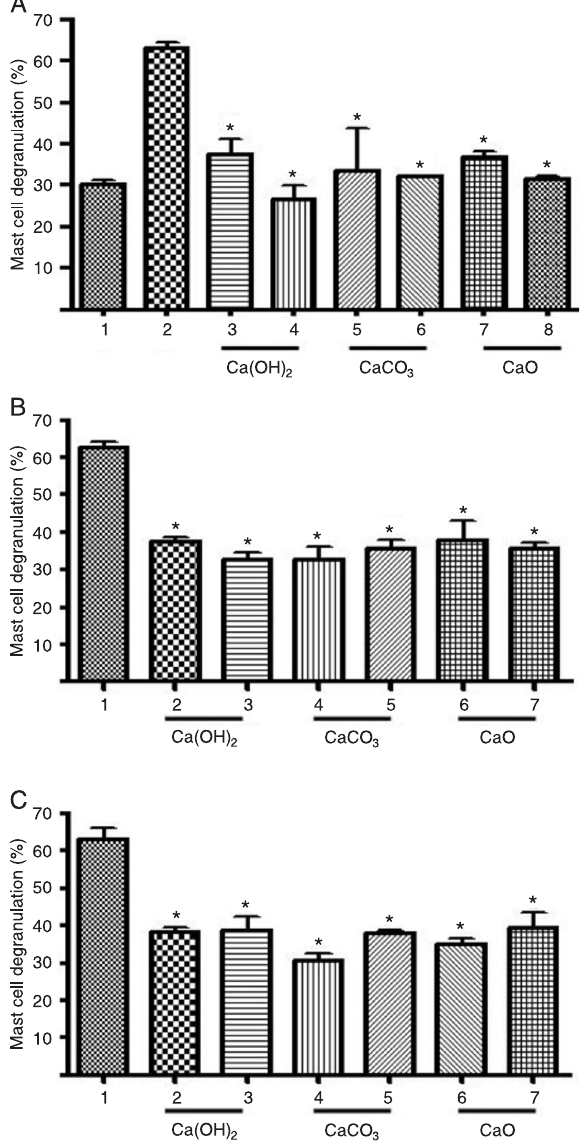
Figure 5. Mast cell degranulation after calcium treatment. A , 1 = Control cells; 2 = 2S albumin pool plus 2S albumin antiserum; 3-8 = 4% Ca(OH) 2 ; 8% Ca(OH) 2 ; 4% CaCO 3 ; 8% CaCO 3 ; 4% CaO; 8% CaO plus 2S albumin serum, respectively. B , 1 = native 2S albumin pool plus 2S albumin antiserum; 2-7 = 2S albumin treated with 4% Ca(OH) 2 ; 8% Ca(OH) 2 ; 4% CaCO 3 ; 8% CaCO 3 ; 4% CaO, and 8% CaO (2S albumin serum included in all sam - ples). C , 1 = castor cake plus 2S albumin antiserum; 2-7 = castor cake treated with 4% Ca(OH) 2 ; 8% Ca(OH) 2 ; 4% CaCO 3 ; 8% CaCO 3 ; 4% CaO; 8% CaO (2S albumin serum included in all samples). Data are reported as means ± SD for 3 experiments (mast cell preparations from different rats). *P < 0.001 compared to positive control (one-way ANOVA followed by the Tukey